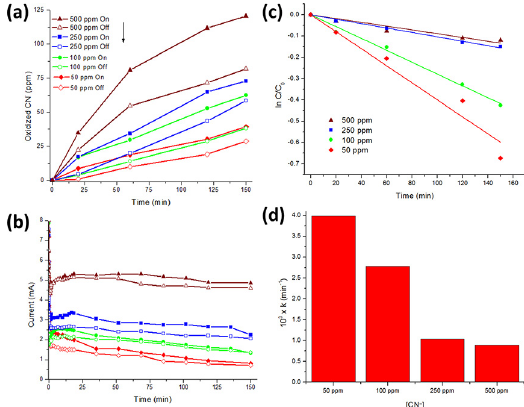
Figure 10. (a) Photoelectrocatalytic (On) and electrocatalytic (Off) oxidation of CN - at different concentrations vs. time, and (b) current transients. (c) ln(C/C ) vs. Time for photoelectrocatalytic Figure 9. Photoelectrocatalytic oxidation of CN - (100 ppm, pH=11) 0 process at different cyanide concentrations. (d) Effect of the on pristine TiO , TiO -T, TiO -NF and TiO -TNF films during 150 2 2 2 2 minutes: a) kinetic curves and b) current transients. 64% CN - degradation after 2 hr. The remaining TiO -NF, 2 TiO -T and pristine TiO samples provided a 55 %, 48 % 2 2 and 32 % CN - removal, respectively. Furthermore, Figure 9b shows the cronoamperograms generated during the PEC experiments. In all cases, there is a drastic current drop followed by an increase until a maximum current value is reached, and then it slowly falls down to the end of the test. In previous studies, it was observed that the variation of the current with time is related to the morphology of the films, i.e. their thickness and porosity 5 . Nonetheless,